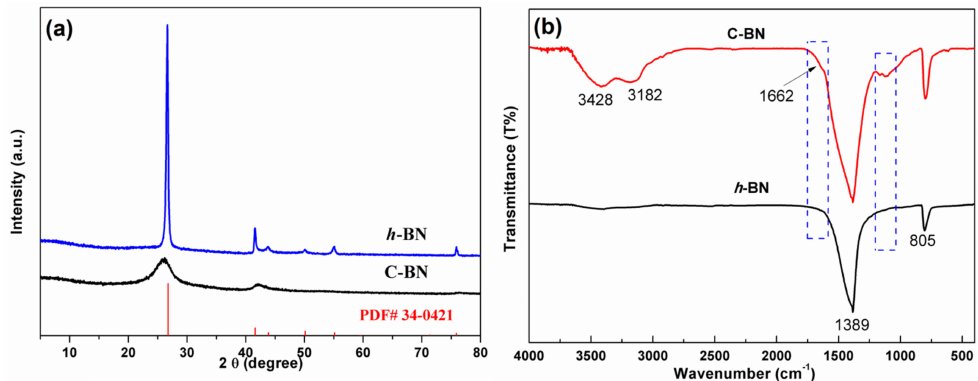
Figure 1. ( a ) XRD patterns and ( b ) FTIR spectra of h -BN and C-BN.